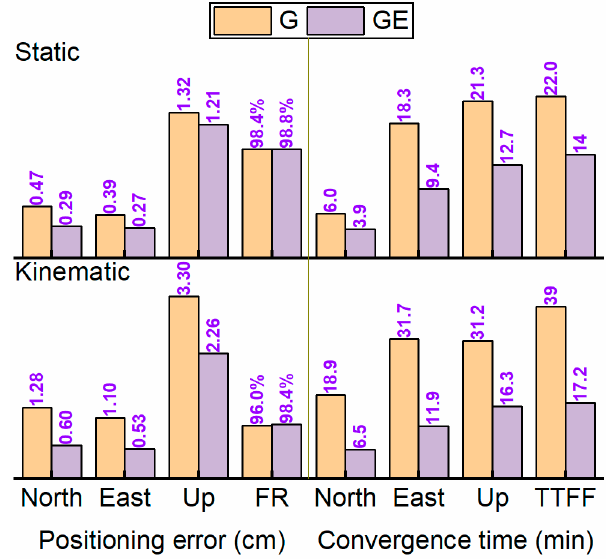
Figure 9. Average performance of multi-GNSS PPP AR in static ( top ) and kinematic ( bottom ) mode with COM products. FR is defined as the ratio of the number of fixed epochs to the number of total epochs after TTFF and TTFF means time to first fix. The specific value is recorded at the top of the bar.